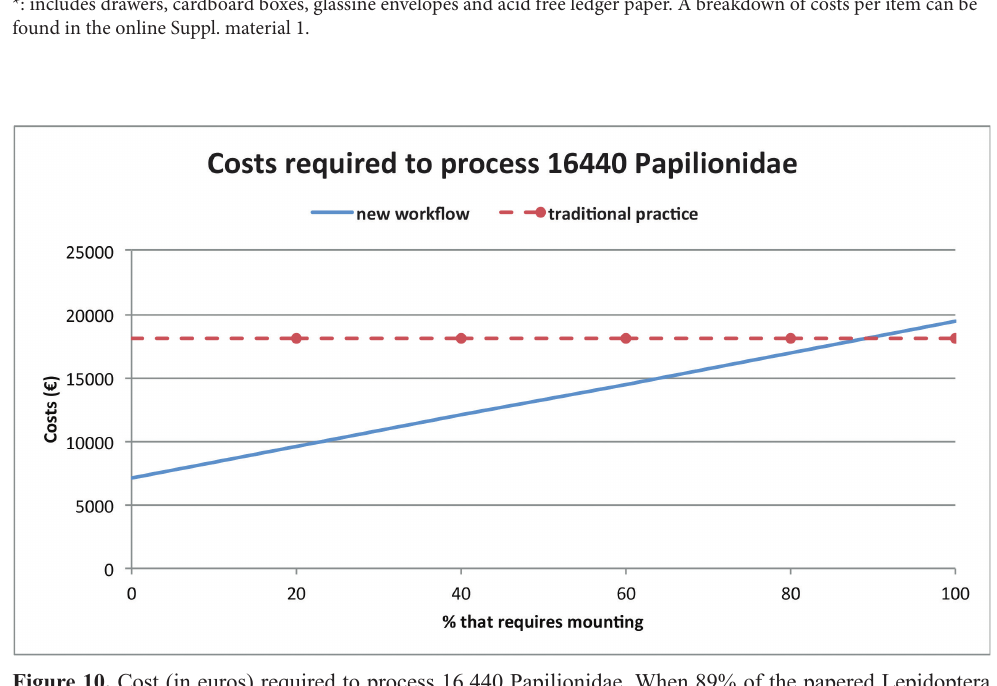
Figure 10. Cost (in euros) required to process 16,440 Papilionidae. When 89% of the papered Lepidoptera collection requires mounting after digitization, the new workflow will become cost-inefficient.